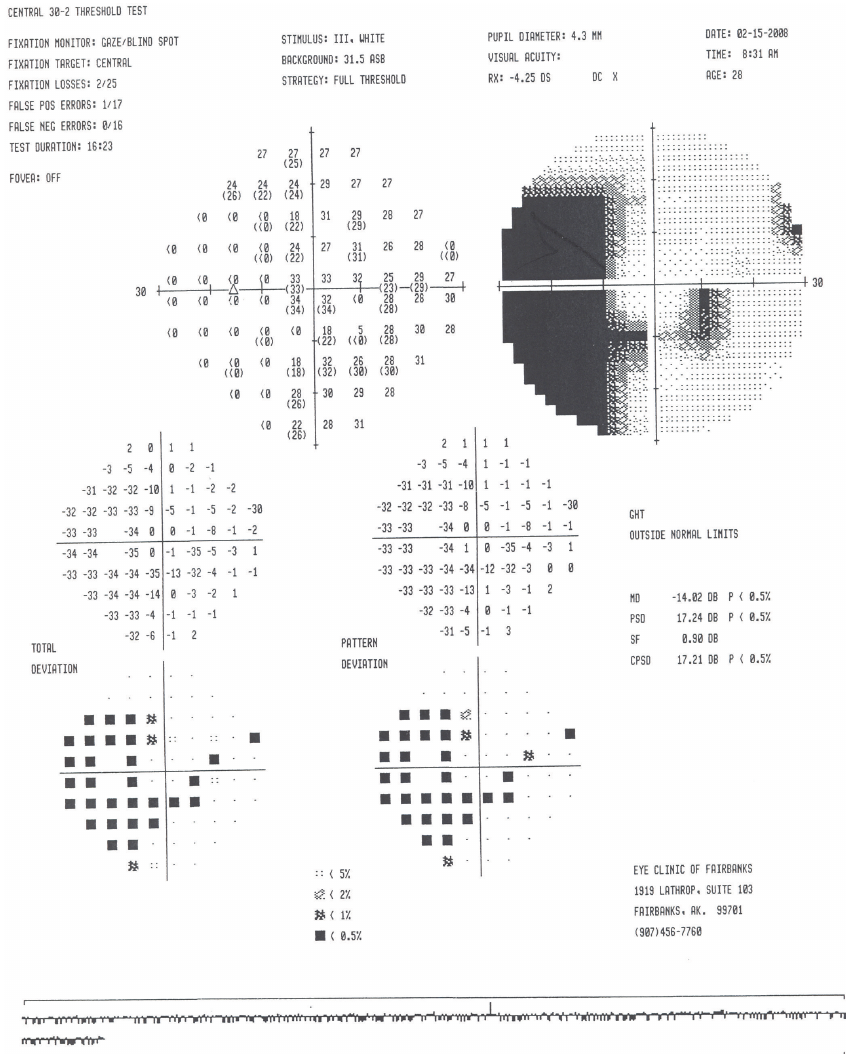
Figure 6: Visual field 30-2 (left